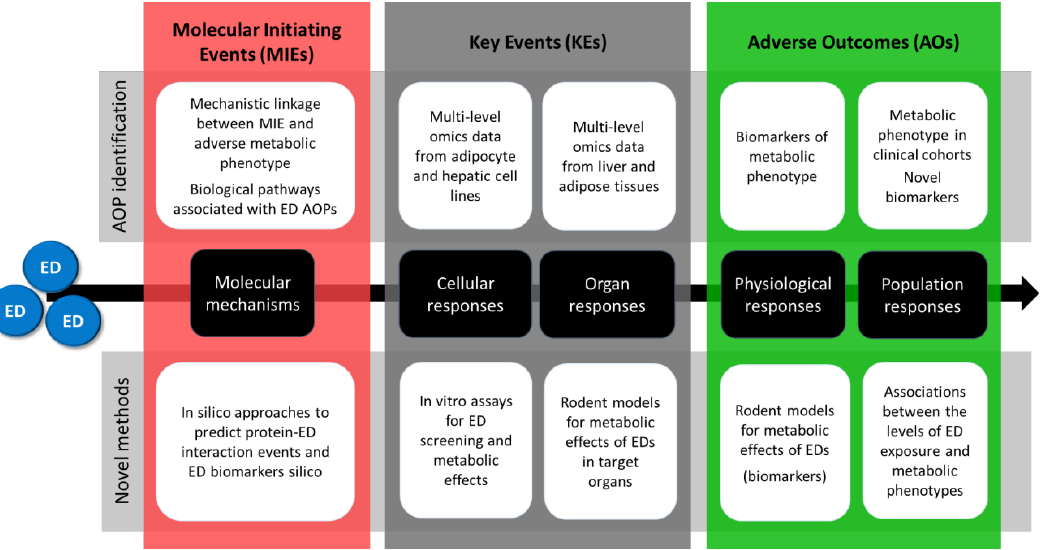
Figure 1. Summary of the overall approach of EDCMET with two parallel, intertwined work streams for the development of novel candidate methods for regulatory use and for the identification of novel adverse outcome pathways (AOPs).